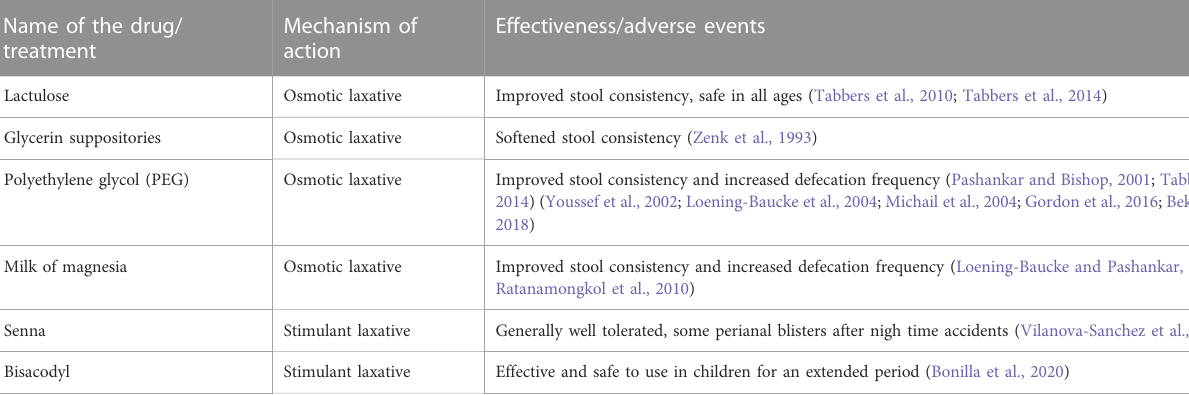
TABLE 2 Conventional treatments for constipation in children. Name of the drug/